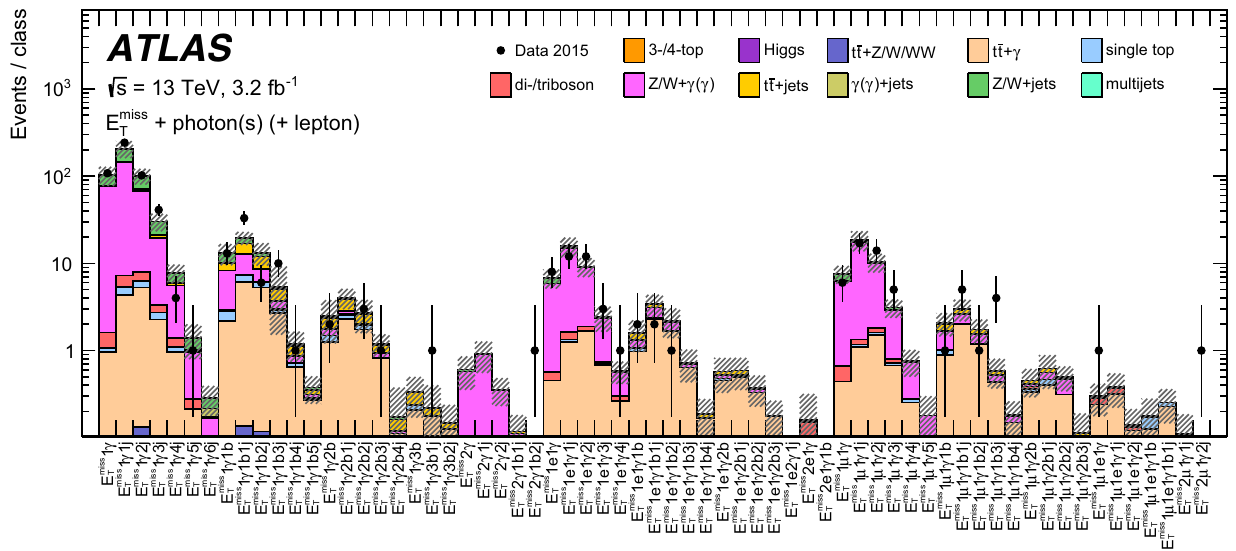
Fig. 20 The number of events in data, and for the different SM back- ground predictions considered, for classes with large E miss photon, leptons and ( b -)jets. The classes are labelled according to the